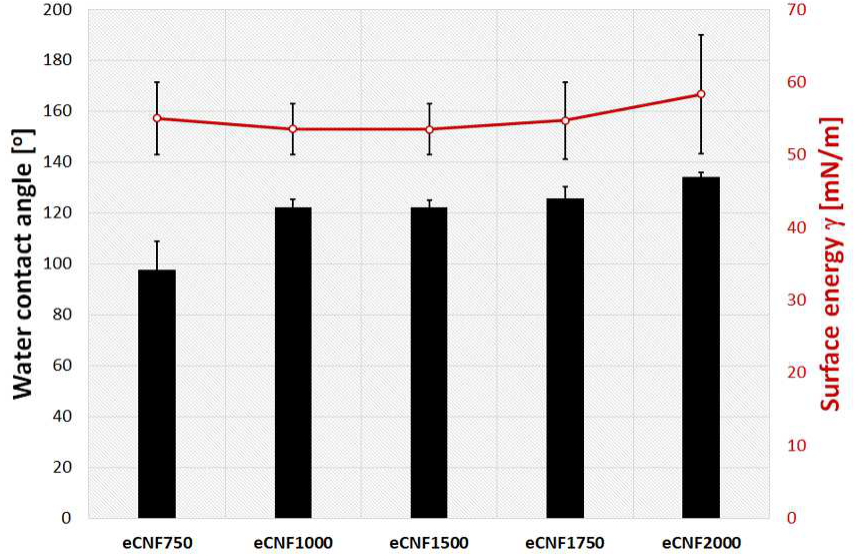
Figure 7. Water contact angle values and surface energy for eCNFs after carbonization at different temperatures.